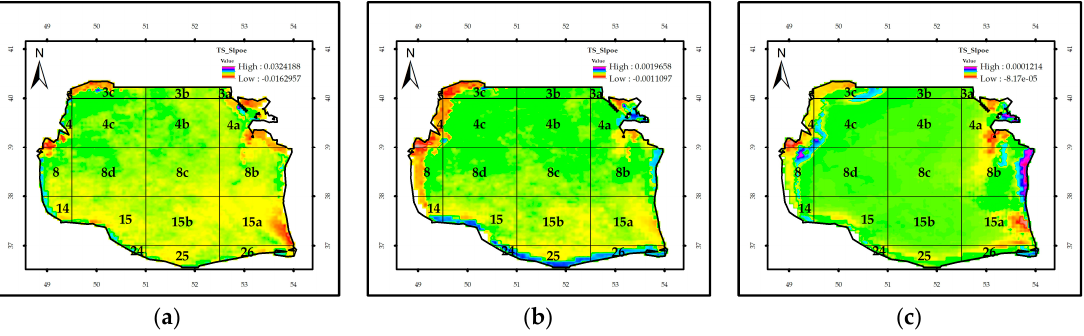
Figure 8. The change rate of bio-optical parameters in the SCS: ( a ) Chl-a (mg.m − 3 ), ( b ) attenuation ffi cient (m − 1 ), and ( c ) Rrs_555nm (Sr − 1 ) during 1998–2015 time coefficient (m − 1 ), and ( c ) Rrs_555nm (Sr − 1 ) during 1998–2015 time period. coe